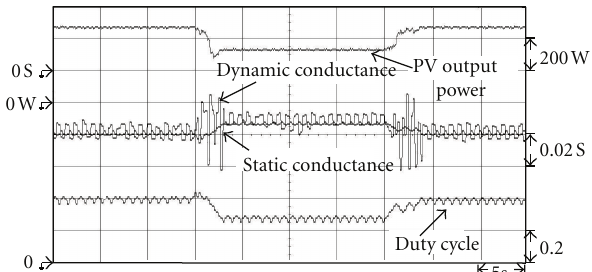
Figure 17: Measured output power, dynamic conductance, static conductance, and duty cycle waveforms of a PV module array using the proposed extension method under irradiation that dropped from 1,000 W/m 2 to 700W/m 2 and then increased back up to 1,000 W/m 2 .